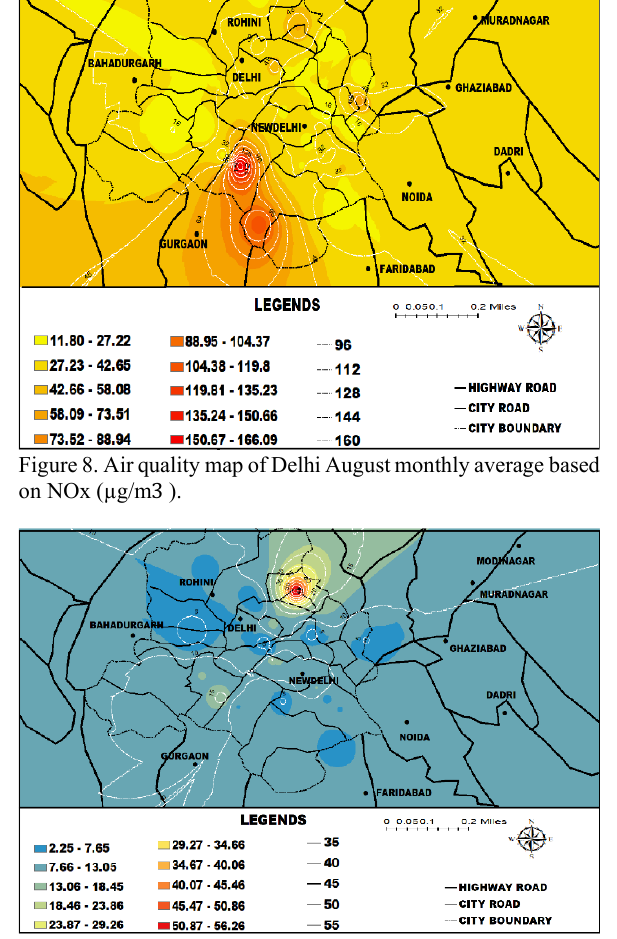
Figure 9. Air quality map of Delhi August monthly average based on SOx (µg/m 3 ).